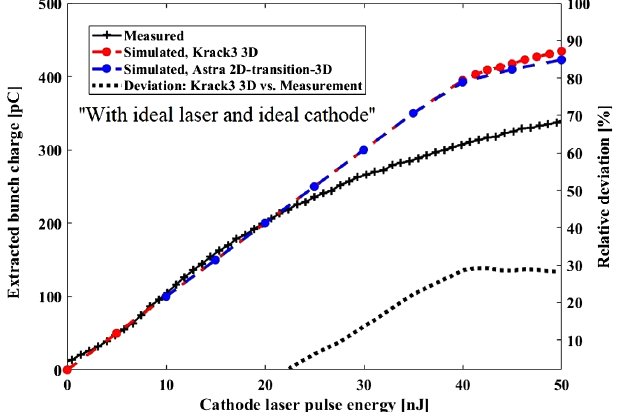
FIG. 12. Comparisons of a measured emission curve with different numerical approaches using an ideal electron bunch with a uniform round transverse distribution at the